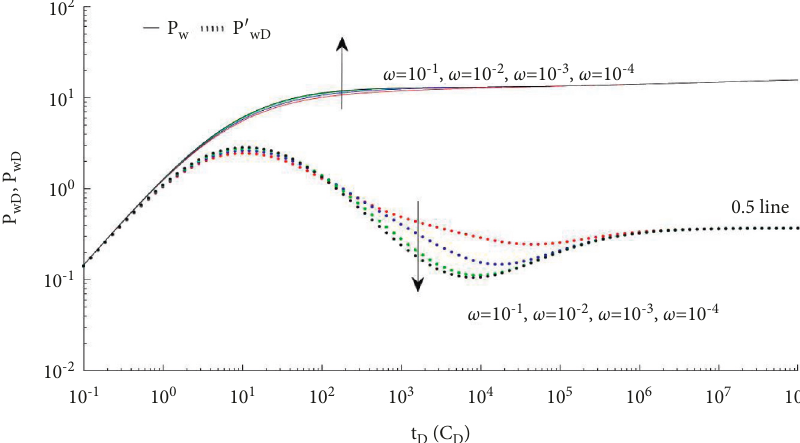
Figure 3: Dimensionless pressure of vertical wells under the infinite outer boundary influenced by ω ( C